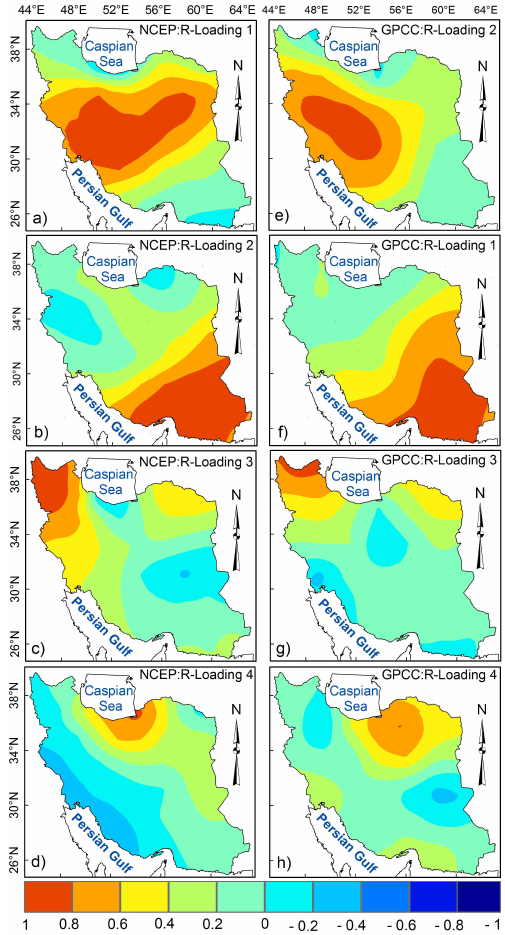
Fig. 5. The four Varimax rotated loadings of the SPI field on 24- month time scale for: (a–d) NCEP/NCAR, (e–h)